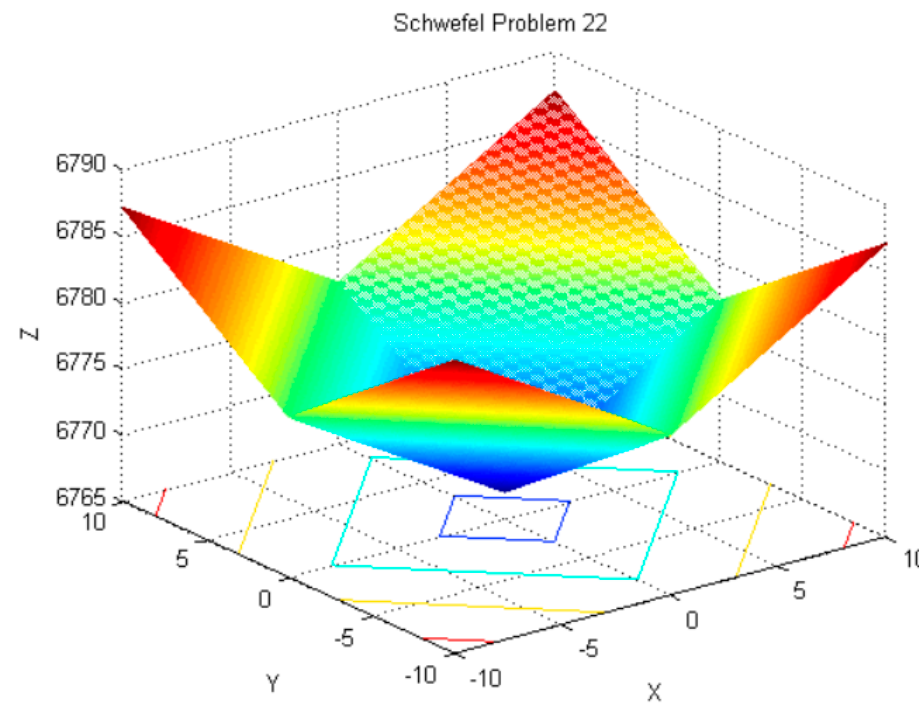
Figure 10. Three-dimensional graph of Schwefel’s problem 22.